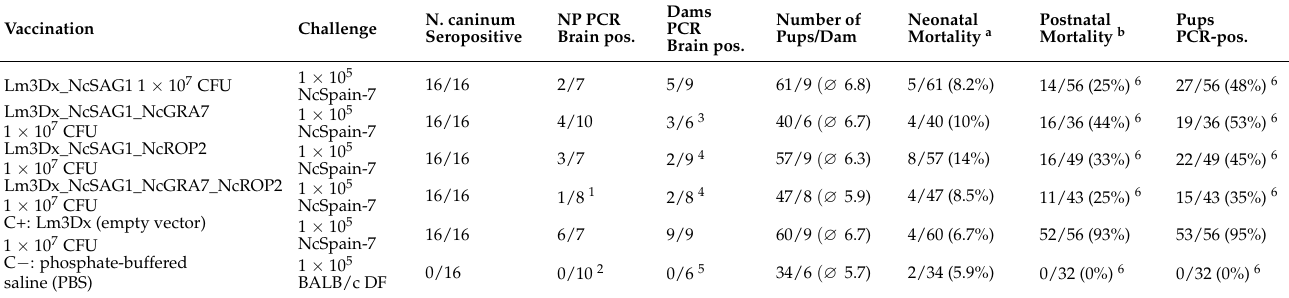
Table 2. Compilation of the results of the vaccine study, including serological analysis, parasite load, litter size and mortality rates of non-pregnant and pregnant mice. The infection control group C+ was immunized with the empty vector Lm3Dx and was challenged as well with N. caninum tachyzoites. The animals in the negative control group C − received PBS and were inoculated with 1 × 10 5 BALB/c dermal fibroblasts. Mice were euthanized 25 days post-partum, and the cerebral par- asite load of non-pregnant and pregnant animals as well as of surviving pups was quantified by RT- qPCR. Statistical analysis between animals from the different vaccine groups and the positive con- trol group was performed by the Chi-squared (and Fisher’s exact) test with the GraphPad Prism software. p -values lower than 0.05 were considered statistically significant.